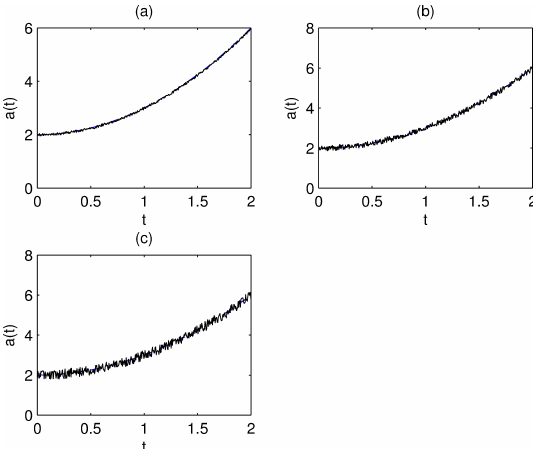
Fig. 3. The exact and approximate solutions of a(t),(a) for 1 % noisy data, (b) for 5 % noisy data, (c) for 10 % noisy data. In figure (a)-(c) the exact solution is shown with dashed line.